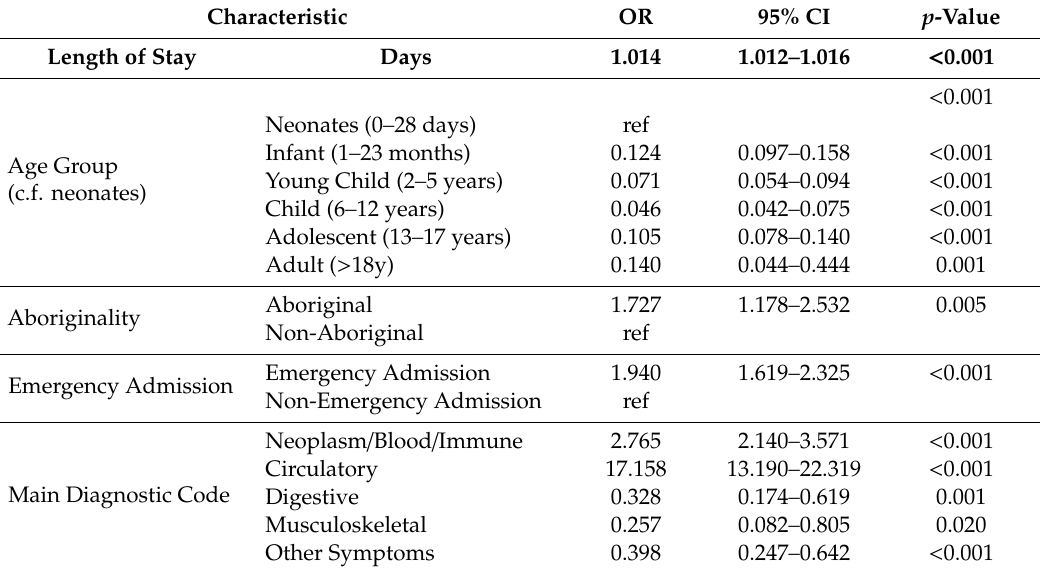
Table 3. Factors associated with death (multivariate logics regression) in all